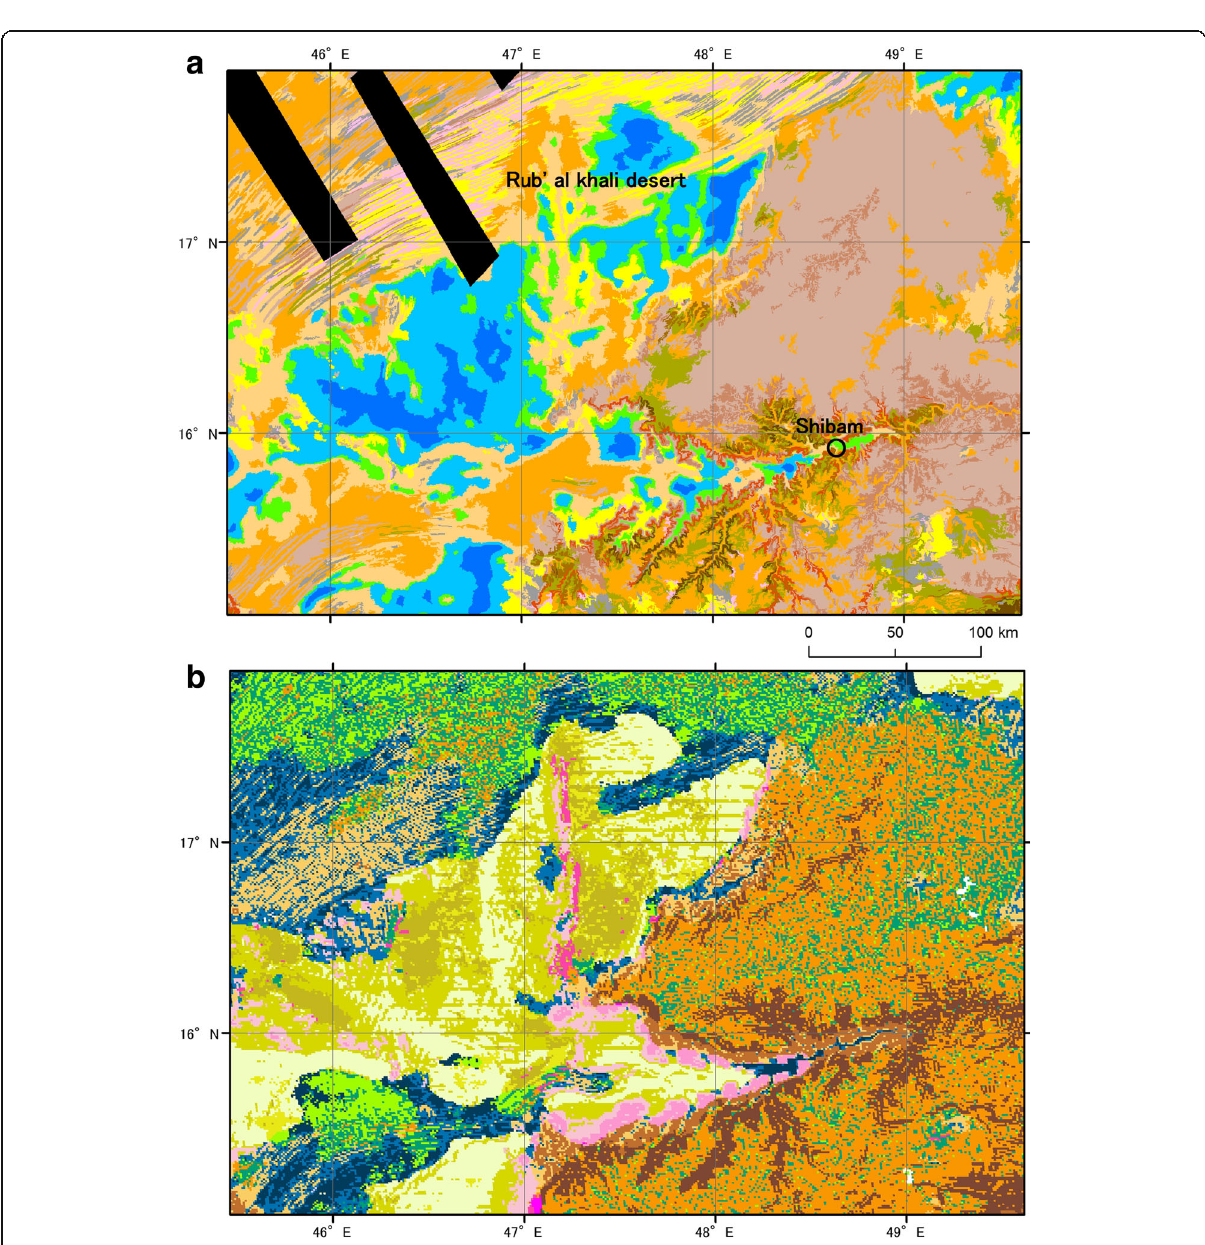
Fig. 15 Comparison of the terrain classification images of the Rub ’ al khali. a Results from of this study, using the 280 m DEM. b Iwahashi and Pike (2007), using a 1 km